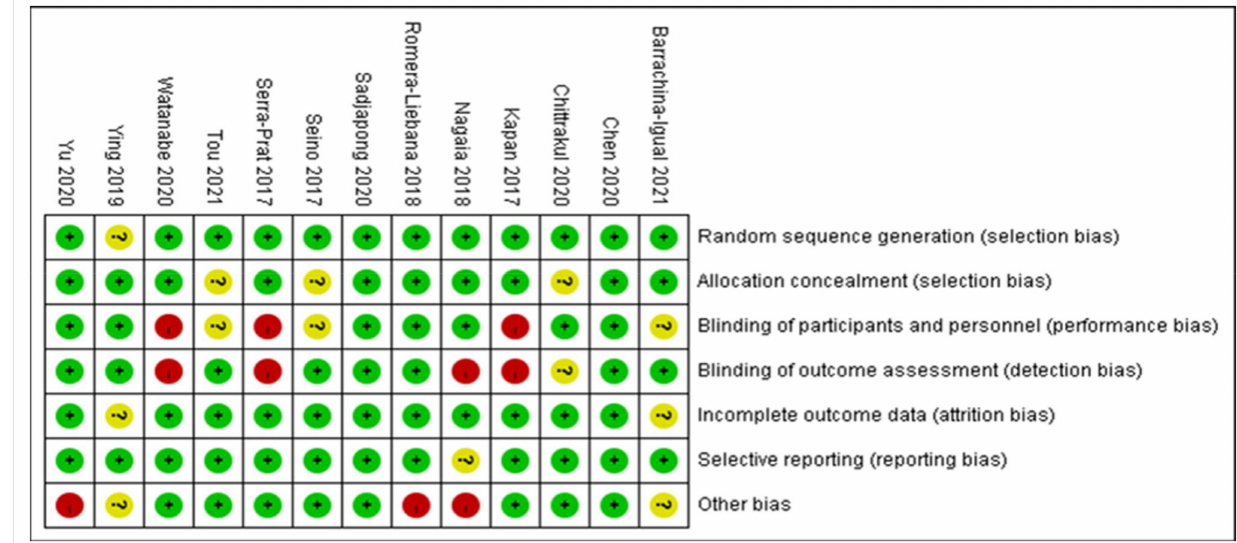
Figure 2. Risk of bias summary of all included